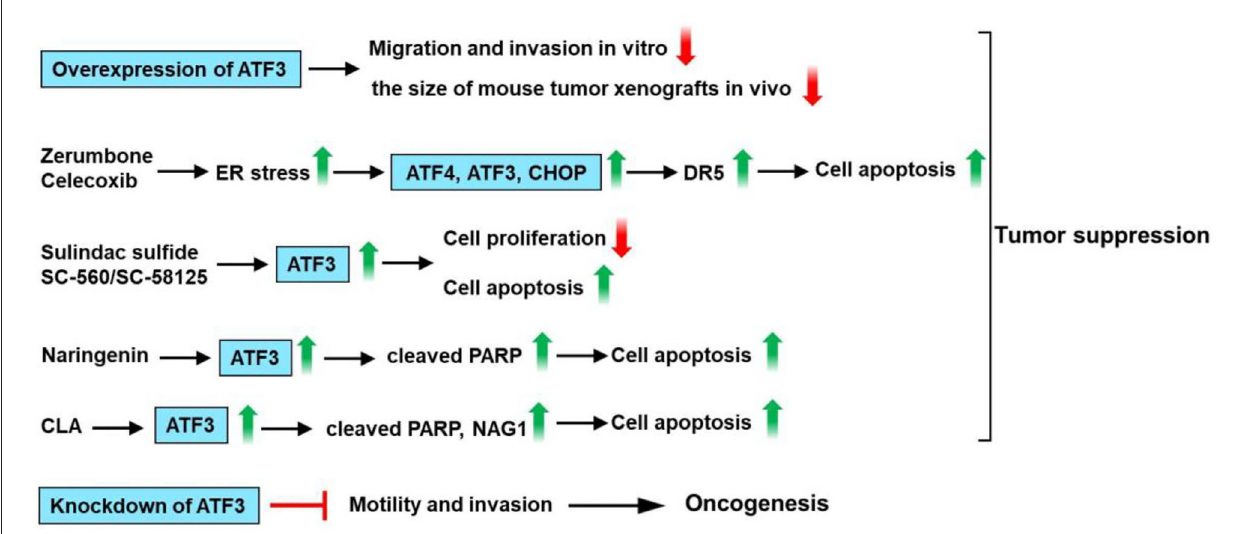
FIGURE 6 | ATF3 plays a critical role in colon cancer. ATF3 overexpression could inhibit the migration and invasion of the HCT116 cells and decrease the size of mouse tumor xenografts. ATF3 promotes death receptor 5 (DR5) induction and apoptotic cell death upon zerumbone (a bioactive sesquiterpene) or celecoxib (a selective inhibitor of cyclooxygenase 2) treatment in human p53-deficient colorectal cancer cells. ATF3 is upregulated by treatment with cyclooxygenase (Cox) inhibitor (sulindac sulfide) or Cox-1 specific inhibitor SC-560 or Cox-2 specific inhibitor SC-58125, suggesting that ATF3 may be involved in sulindac sulfide/SC-560/SC-58125-induced apoptosis and anti-tumorigenic effect in human colon cancer cells. Naringenin (NAR) upregulates ATF3 expression in colon cancer cells. Furthermore, ATF3 overexpression enhances NAR-modulated cleavage of PARP. Trans-10, cis-12-conjugated linoleic acid (CLA) could increase ATF3 expression. In addition, ATF3 modulates trans-10, cis-12-CLA-stimulated non-steroidal anti-inflammatory drug-activated gene-1 (NAG-1) expression and apoptosis in colon cancer cells. These findings suggest that ATF3 acts as a tumor suppressor for colon cancer. However, siRNA-mediated knockdown of ATF3 attenuates motility and invasion of the colon cancer cell. These observations suggest that ATF3 plays a dual role in colon